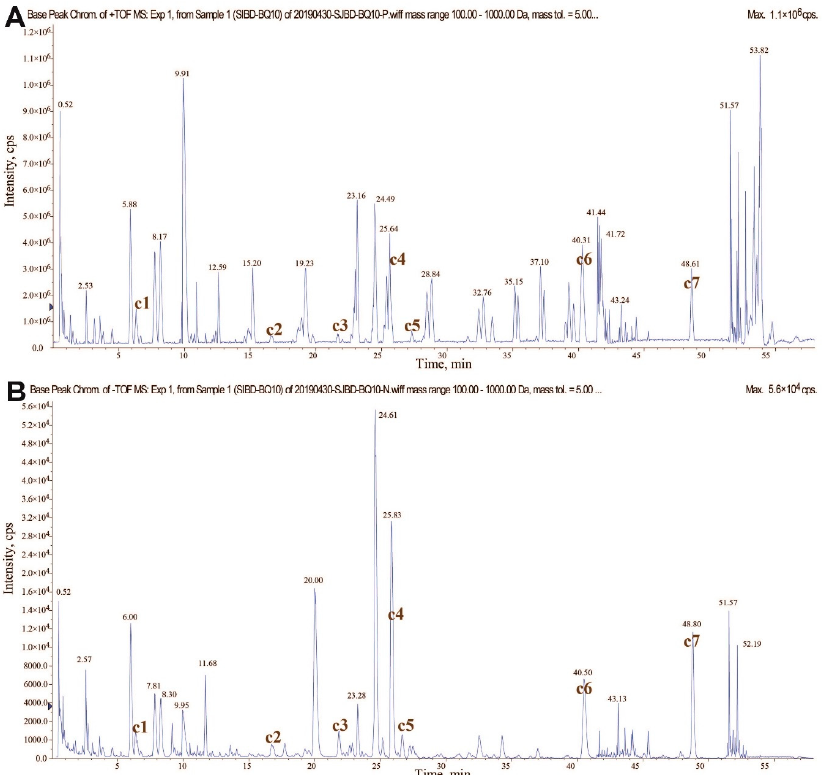
Figure 1. Base peak ion chromatograms of Siji-kangbingdu mixture detected using UPLC-TripleTOF-MS technology. ( A ) Detected in positive ion mode; ( B ) Detected in negative ion mode. In the two panels, the label c1 to c7 represent different compounds: c1—chlorogenic acid, c2—liquiritin, c3—rutin, c4—forsythoside A, c5—isochlorogenic acid A, c6—forsythin, and c7—glycyrrhizic acid.